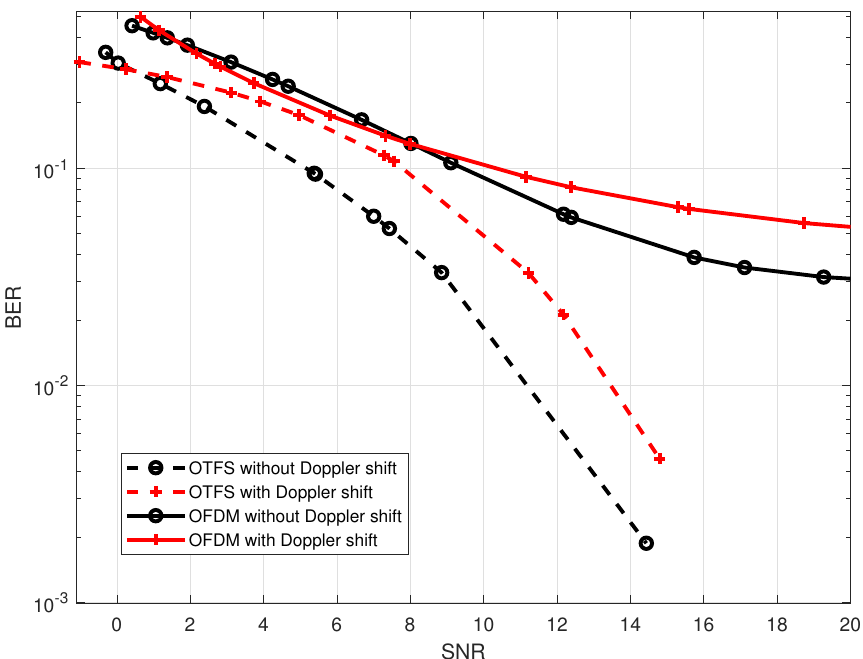
Figure 5. Emulation of the Doppler shift ( f D ≈ 370 Hz) effect on the 5 GHz tone using reverberation chamber. ( a ) Instantaneous spectrum stirrer-off; ( b ) instantaneous spectrum stirrer-on; ( c ) cumulative PSD when the stirrer-off; ( d ) cumulative PSD when the stirrer-on; ( e ) spectrogram when stirrer-off; ( f ) spectrogram when stirrer-on.